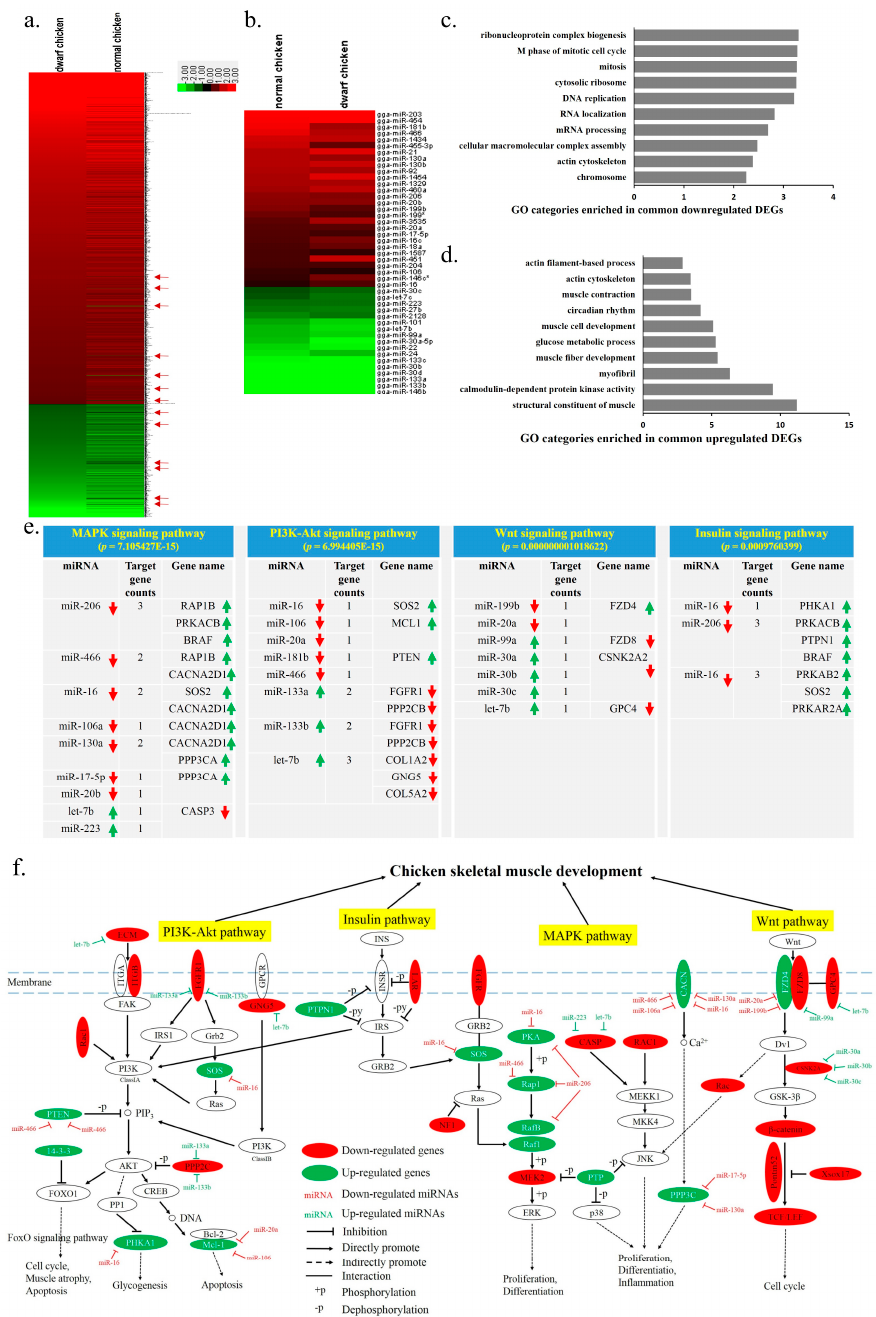
Figure 6. Functional and network analysis of the common DEGs and DEMs between E14 and 7w. ( a ) Heat map of 1355 common down-regulated DEGs (red) and 461 common up-regulated DEGs (green) from E14 to 7w in the SLD and normal chickens. Red arrows indicated 13 DEGs that are displayed different expression trend between SLD and normal chickens; ( b ) Heat map of 28 common down-regulated DEMs (red) and 17 common up-regulated DEGs (green) from E14 to 7w in the SLD and normal chickens; ( c ) GO enrichment for the common down-regulated DEGs. The y axis represents GO terms and the x axis represents fold enrichment (with p value < 0.05); ( d ) GO enrichment for the common up-regulated DEGs. The y axis represents GO terms and the x axis represents fold enrichment (with p value < 0.05); ( e ) List of miRNAs and their target genes that are enriched in the MAPK, PI3K-Akt, Wnt and Insulin signaling pathways. Both of the miRNAs and their target genes are differentially expressed between E14 and 7w. Red arrows indicated down-regulated from E14 to 7w, green arrows indicated up-regulated from E14 to 7w; ( f ) A hypothetical regulatory network showing the interaction of the DEGs and DEMs during chicken skeletal muscle development.